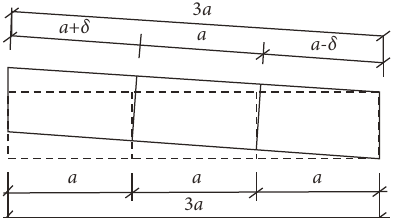
Figure 17: Deformation mechanism of the catwalk.